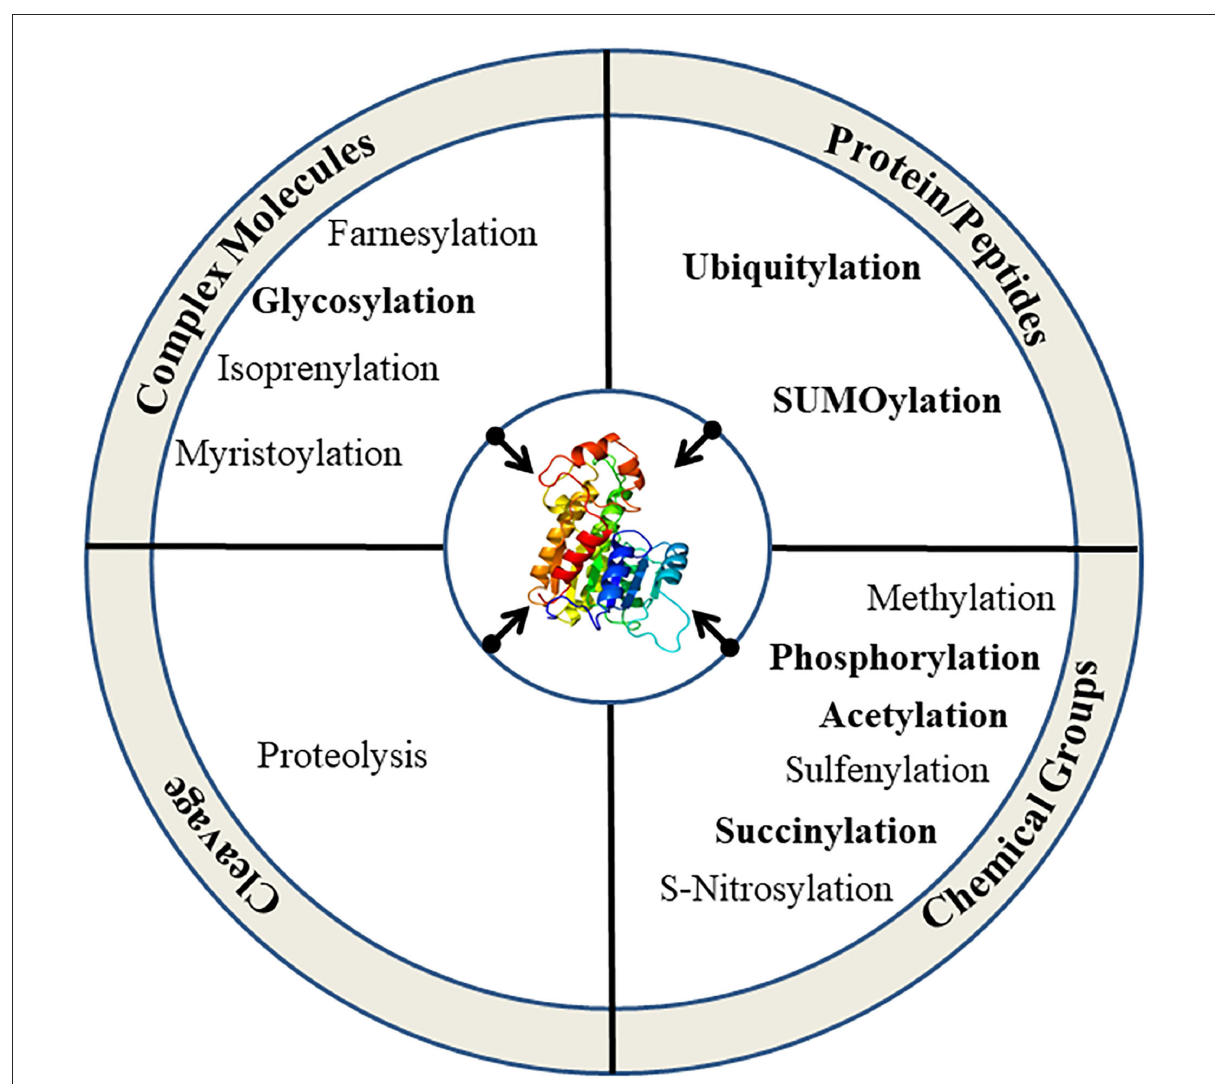
FIGURE1 Types of PTMs in eukaryotic cells. More frequent types of PTMs are